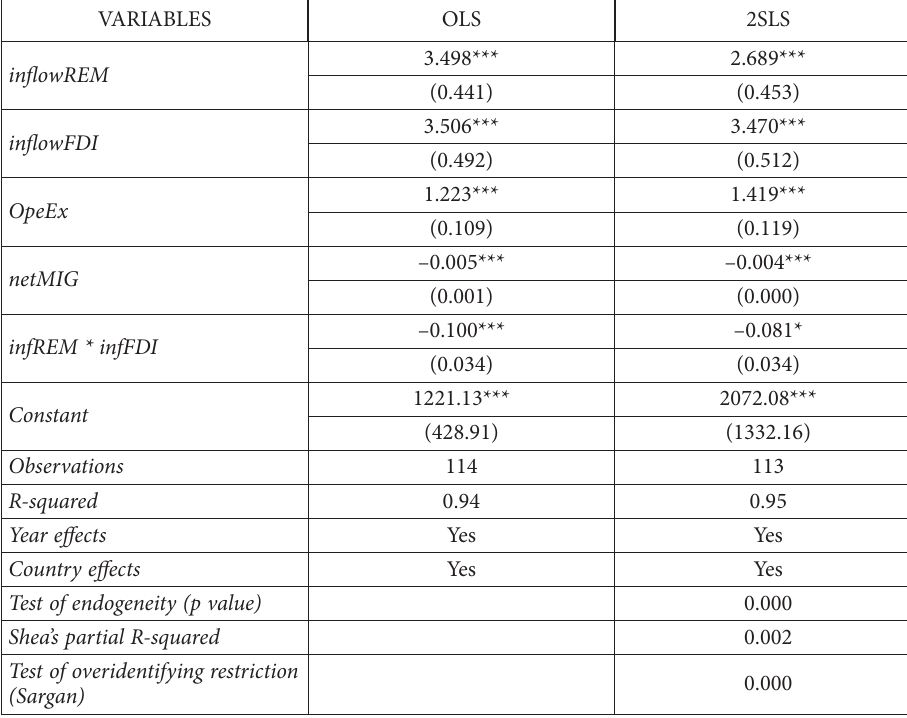
Table 2. Regression estimates of the effect of remittances on economic